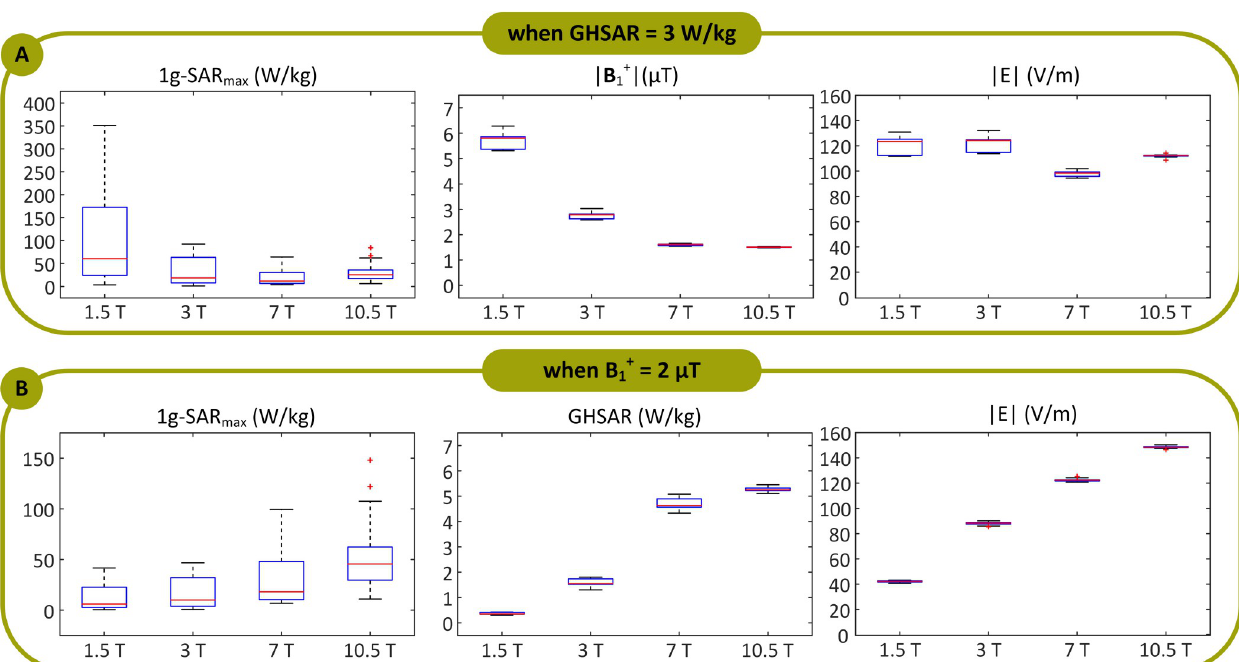
Fig 5. 1g-SAR max , B 1+ , and || E || when the coils’ input powers were balanced to produce a global head SAR (GHSAR) of 3 W/kg, and (B) 1g-SAR max and GHSAR when the coils’ input powers were adjusted to generate an average of B 1+ = 2 μ T, over all 33 DBS lead models for the 1.5 T, 3 T, 7 T, and 10.5 T coils. Box and whisker plots display the range, median, and interquartile range (IQR) of the data. Each outlier was specified with a red ’+’ symbol.